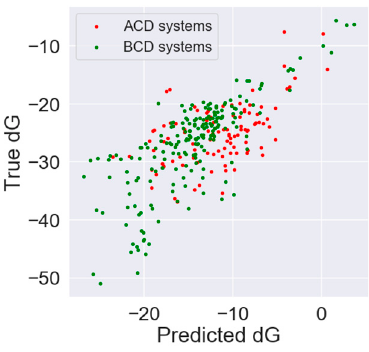
Figure 4. Autocorrelation plot of true and predicted d G for ACD systems (red) and BCD systems (green).